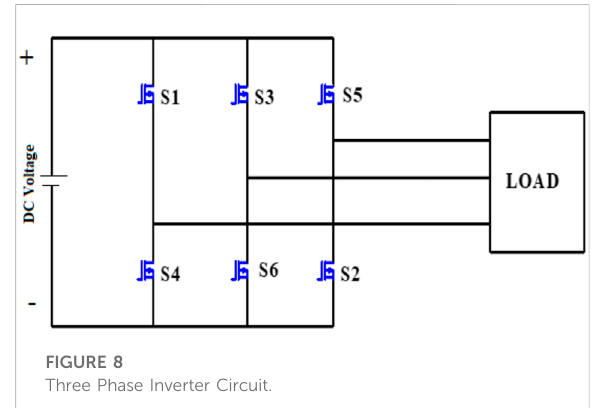
TABLE 1 Switching sequence.